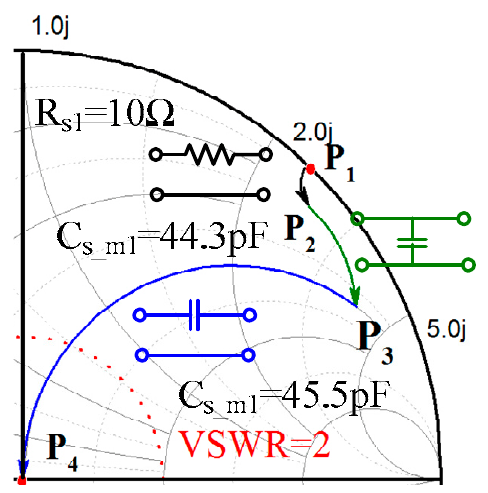
Figure 8. Matching process for series equivalent circuit.